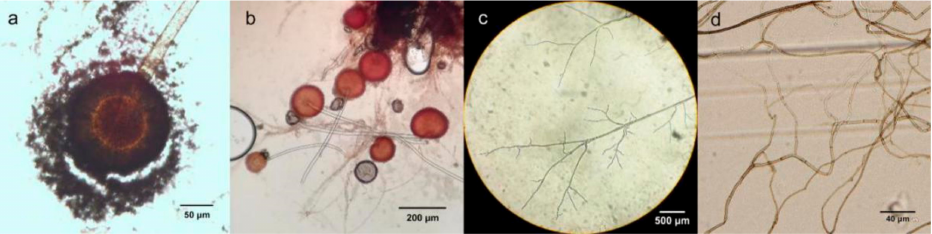
Figure 5. Morphology of pathogens A and B under the microscope. ( a , b ) Vesicles of pathogen A (5 days); ( c , d ) Hyphae of pathogen B (3